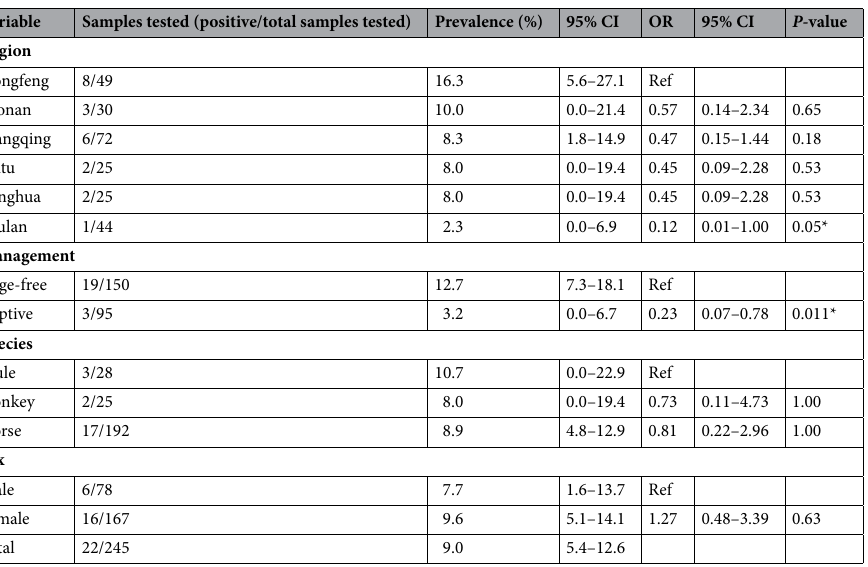
Table 2. Univariate analysis of risk factors associated with Toxoplasma gondii infection in equids in Jilin, China. Ref, reference; 95% CI, confidence interval; *P < 0.05, **P < 0.01.